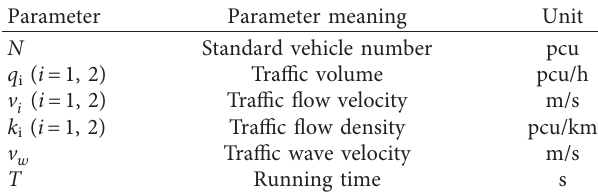
Table 2: Meaning of parameters in equations (3) and (4). Parameter